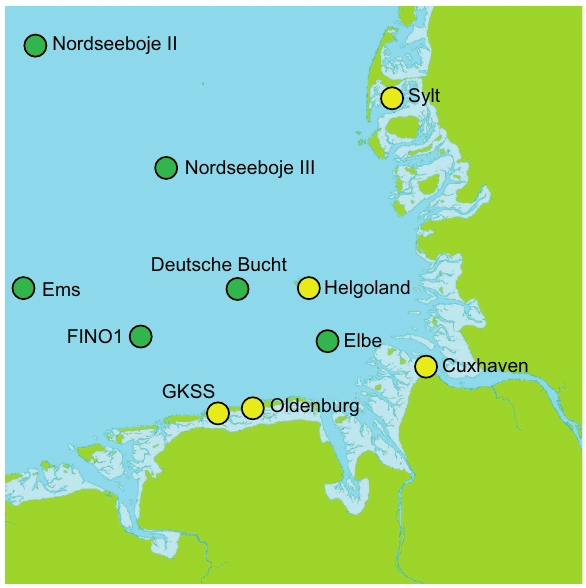
Fig. 4. Fixed stations in the German Bight. Green circles-locations of MARNET stations, yellow circles – coastal stations.